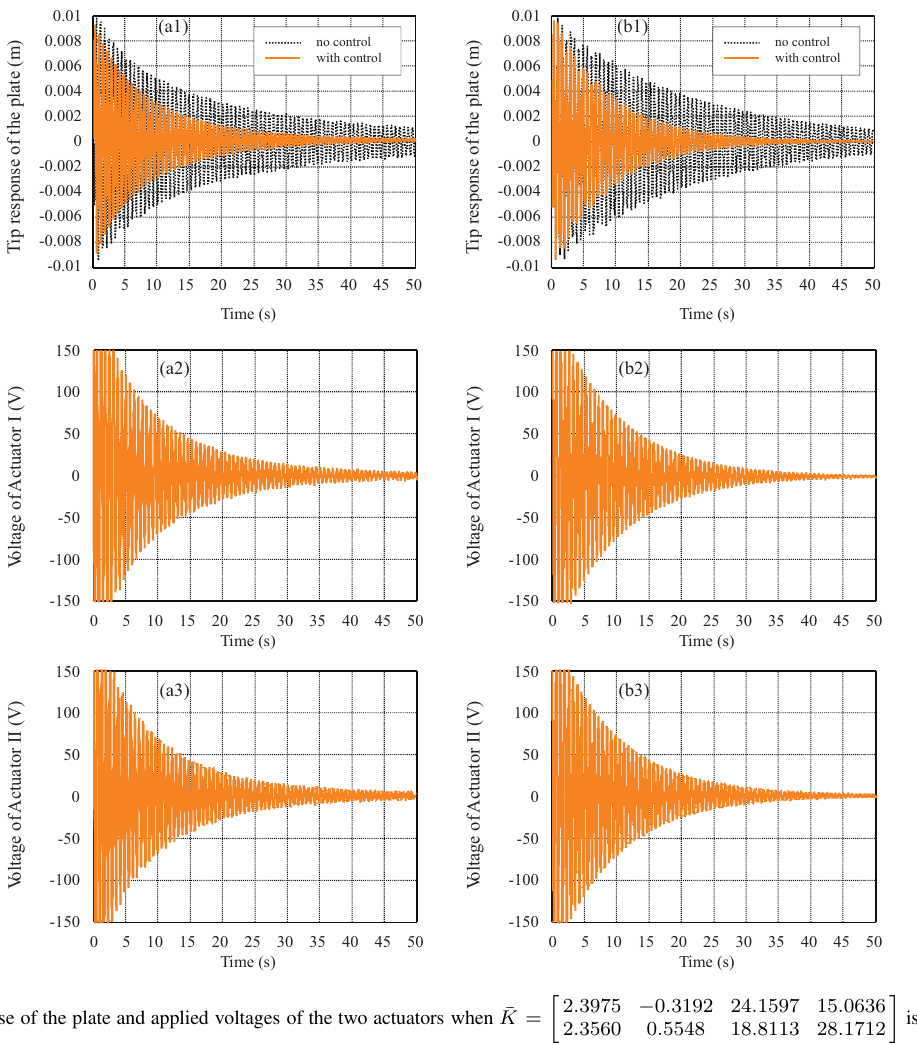
Fig. 13. Response of the plate and applied voltages of the two actuators when ¯ K = plate with time delays ( τ 1 = 0 . 04s , τ 2 = 0 . 06s ) (two actuators case). (a) experimental result; (b) simulation